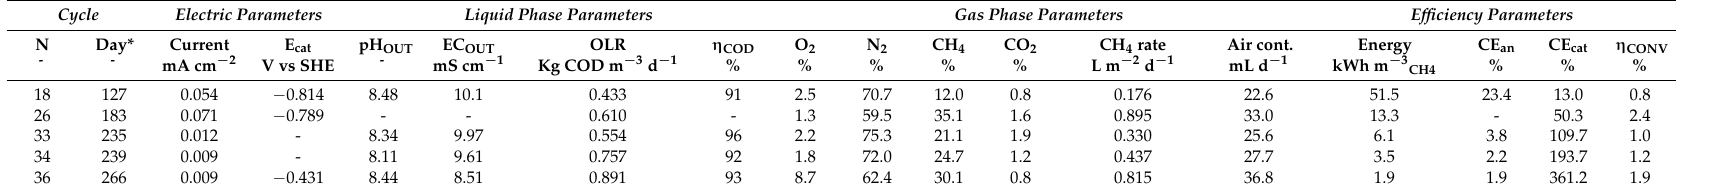
Table A5. Selection of five cycles for BES 1, operated at constant 0.7 V voltage with synthetic medium.